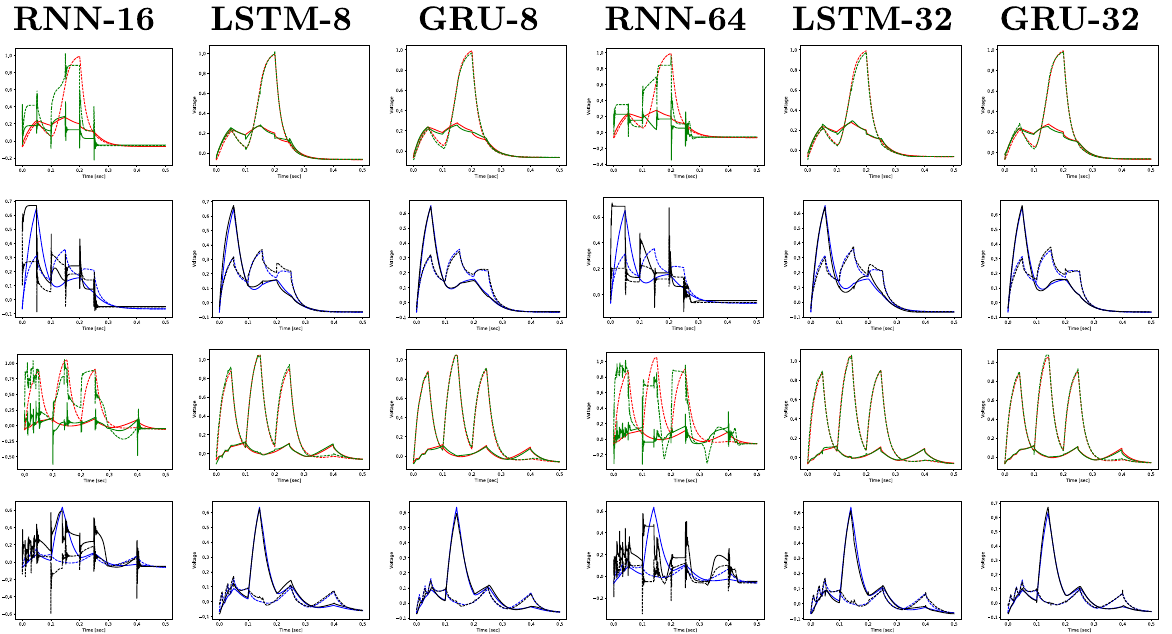
Figure 6. Experiment 1: realistic (red and blue) and predicted (green and black) sequences for DB1 and LUAL (1st and 3rd rows) and PVR and VB1 (2nd and 4th rows) for two sequences of the test set (one selected simulation out of ten).